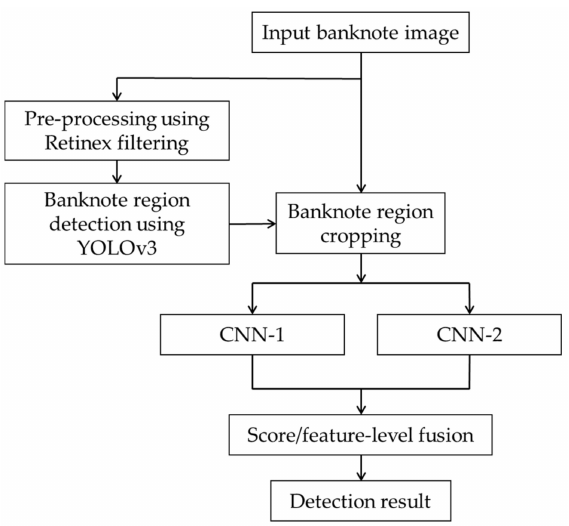
Figure 1. Overall flowchart of the proposed